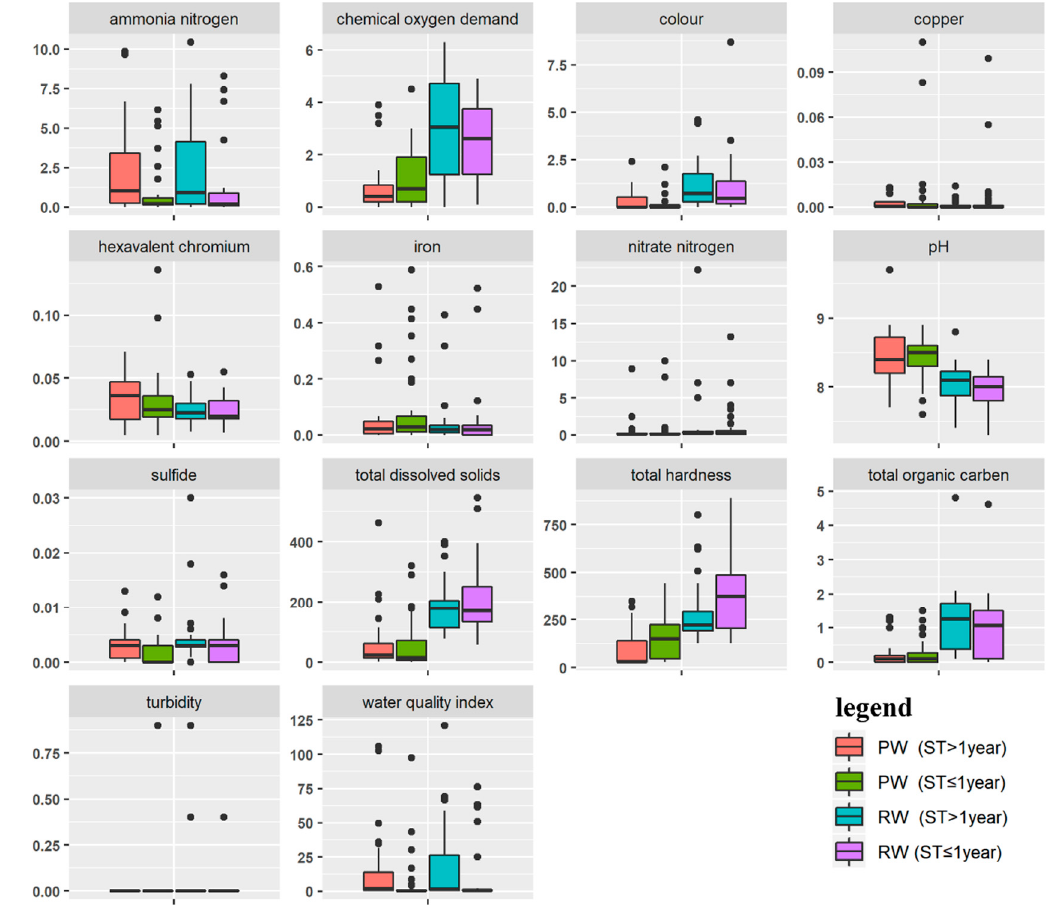
Figure 5. Water quality indicator levels in raw water (RW) and purified water (PW) according to the filter element service time (ST) ( n = 67). Units: color (TCU), turbidity (NTU), ammonia nitrogen (mg/L N), nitrate nitrogen (mg/L N), chemical oxygen demand (mg/L O 2 ), total hardness (mg/L CaCO 3 ), water quality index and pH (standard units), and other parameters (mg/L).